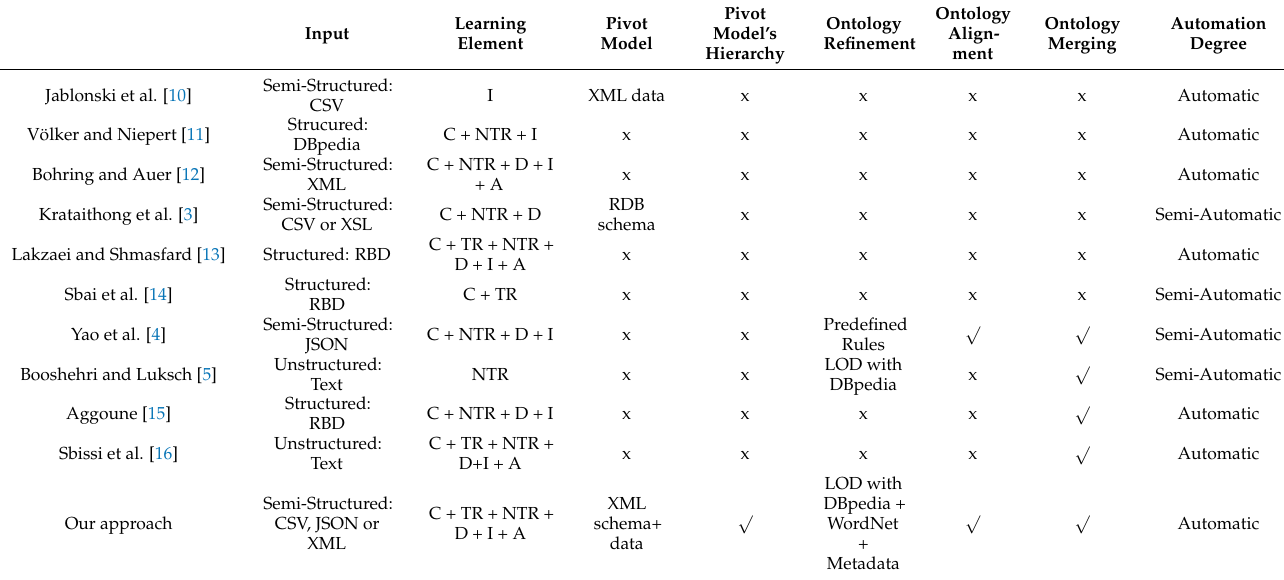
Table 1. Tabular comparison of different ontology learning approaches based on main distinguishing criteria. Input Learning